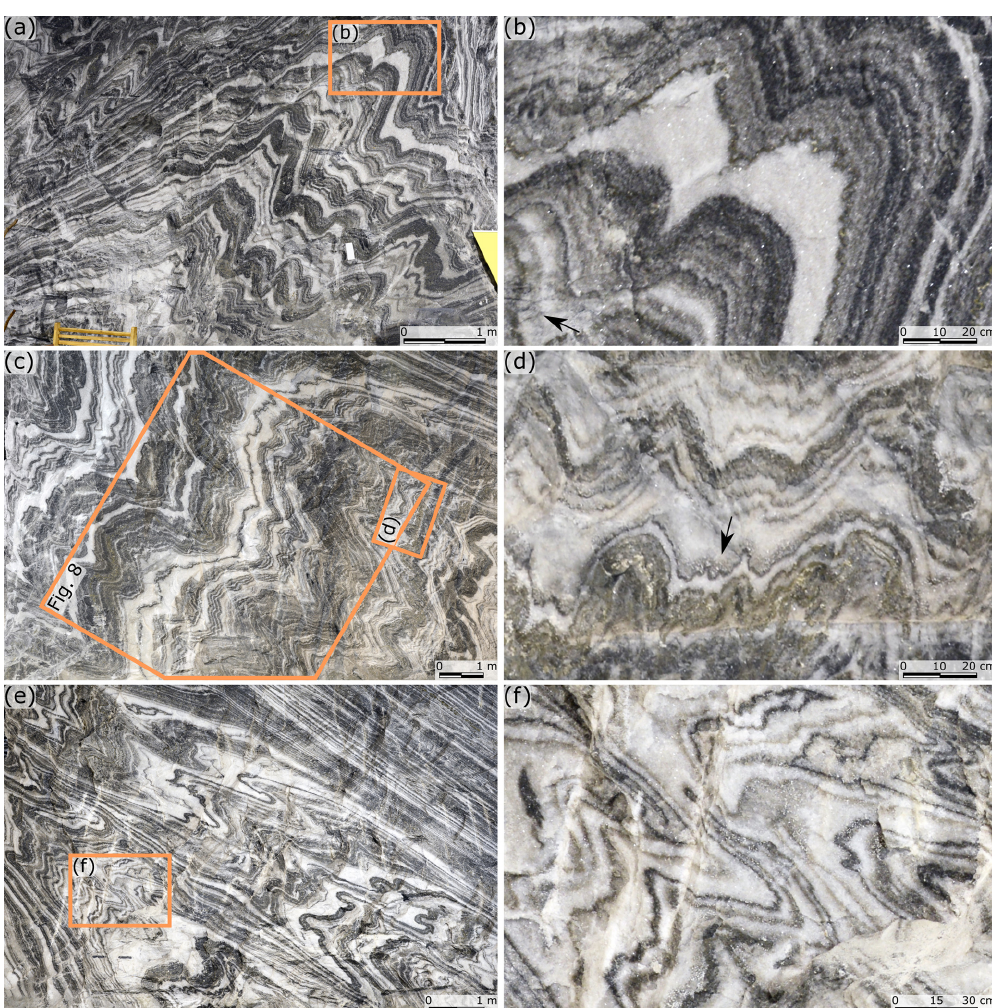
Figure 5. Fold structures on the (a, b) western-facing wall of pillar F48, (c, d) eastern-facing wall of pillar E50, and (e, f) eastern-facing wall of pillar D50E. See text for further